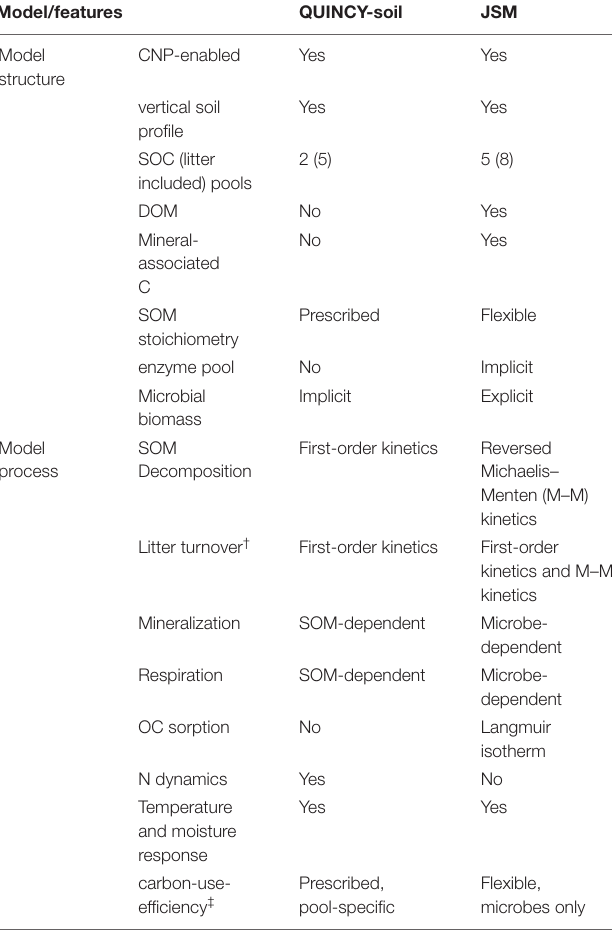
TABLE 2 | Comparison of model features between the soil module in QUINCY (QUINCY-soil) and Jena Soil model (JSM).